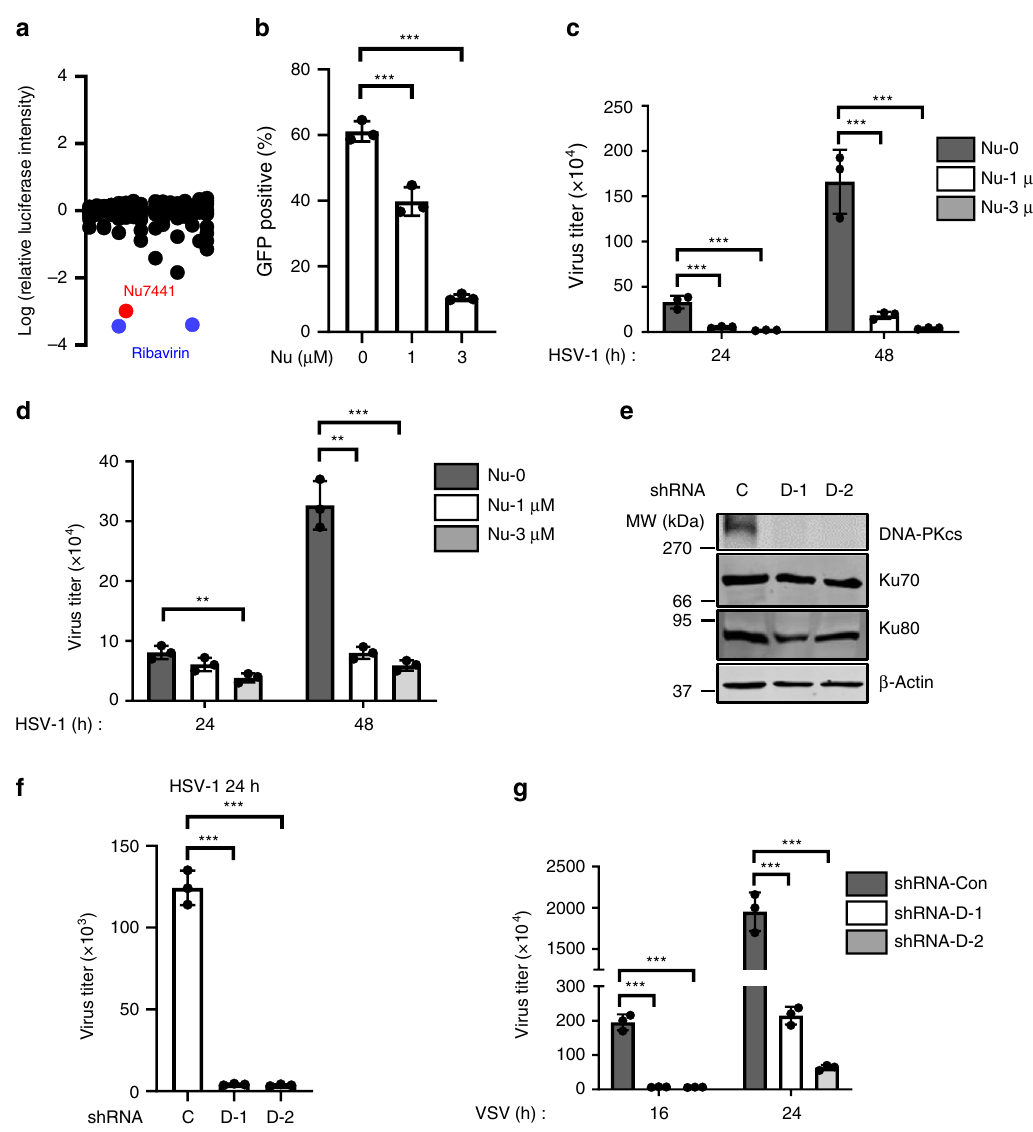
Fig. 1 DNA-PK inhibition suppresses VSV and HSV-1 replication. a THP-1 cells were treated with ~150 compounds (10 μ M) and infected with VSV- luciferase (MOI = 0.01). Luciferase activity was measured 16 h post-infection and the values were normalized to solvent control. b THP-1 cells were treated with Nu7441 and infected with VSV-GFP (MOI = 0.01). GFP-positive cell percentage was quanti fi ed by fl ow cytometry at 16 h post-infection. p =